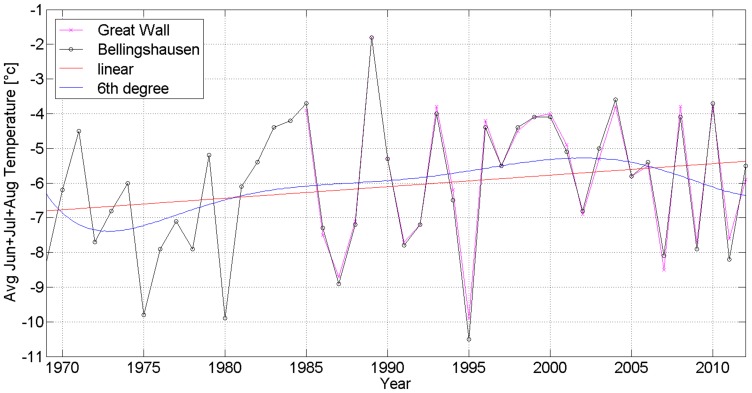
The average winter monthly temperature (June, July and August) at Station Bellingshausen and Great Wall Station on Fildes Peninsula, Antarctica, by using MATLAB and calculating with linear and 6th degree [55], [56].